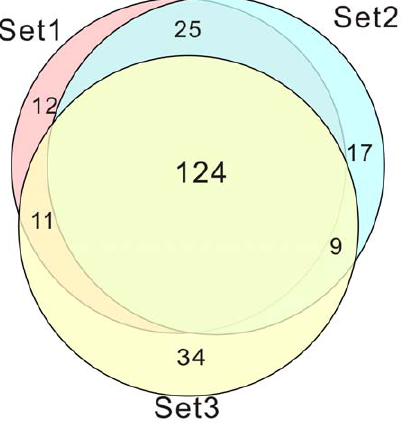
Characteristics